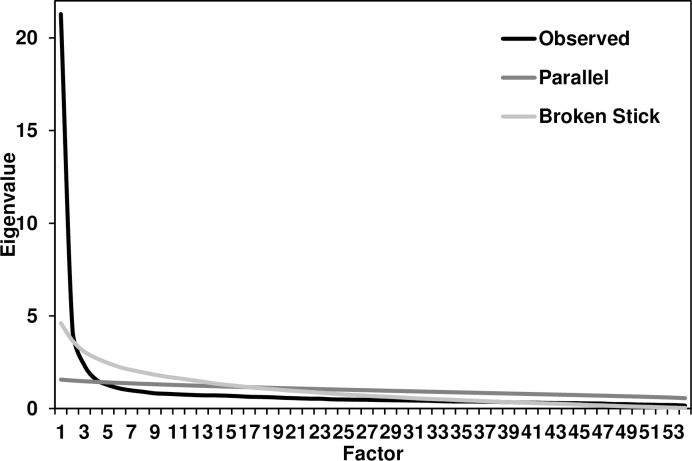
Factors in Study 1.Scree plots of Eigenvalue by number of factors: Observed, parallel analysis, and broken-stick analysis.